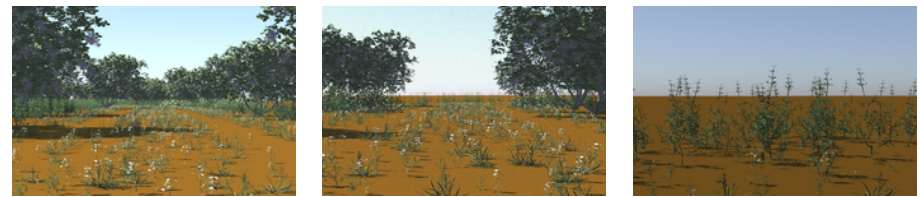
Figure 3. Three sample images from four-class high-definition dataset. best viewed in color.